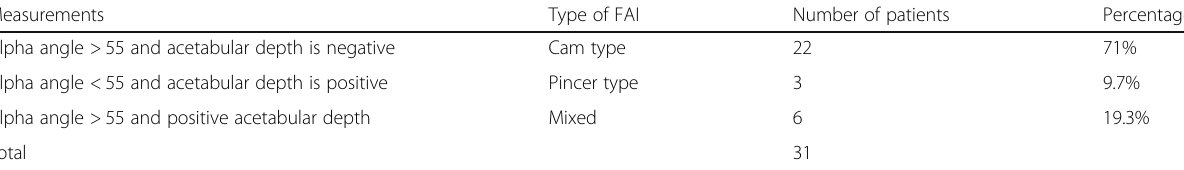
Table 2 Types of FAI in the study according to alpha angle and acetabular depth measurements